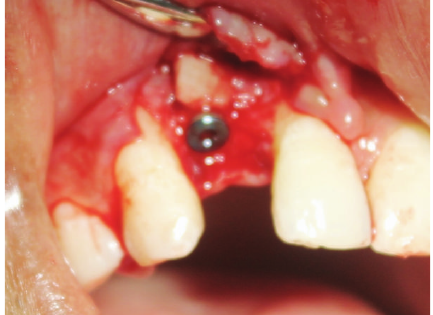
Figure 9: Chorion membrane placed over graft.